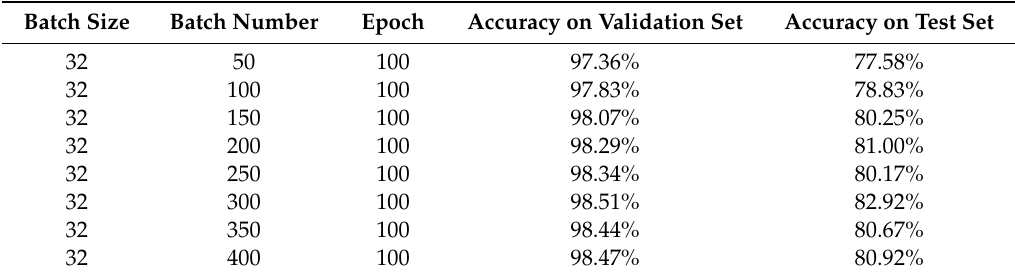
Table 4. Intrusion detection accuracy of di ff erent batch number.